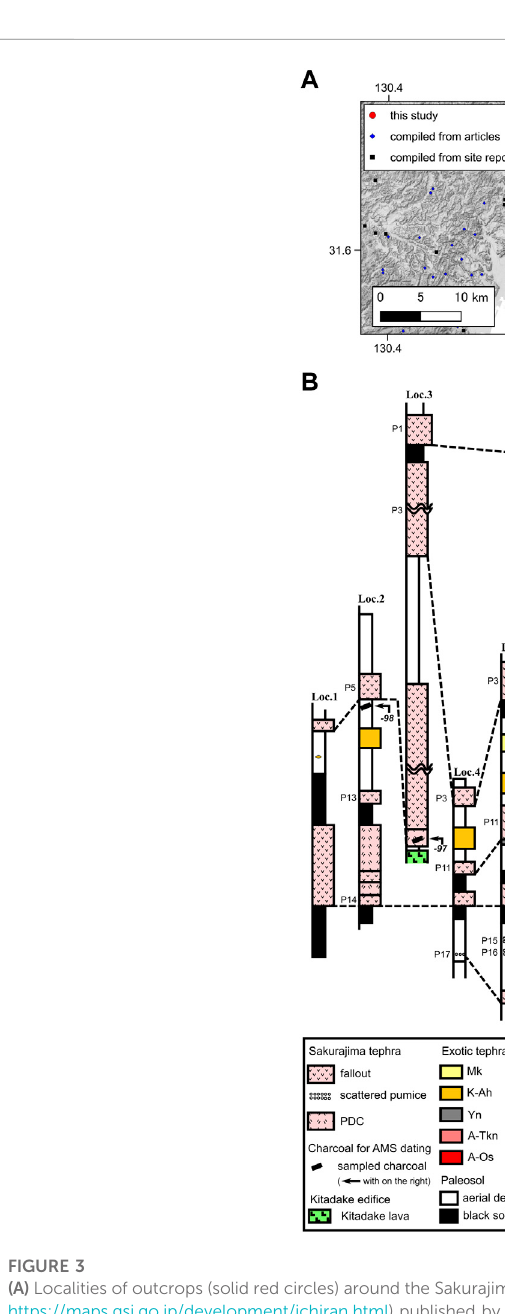
(Table 1). Representative stratigraphical relationships of